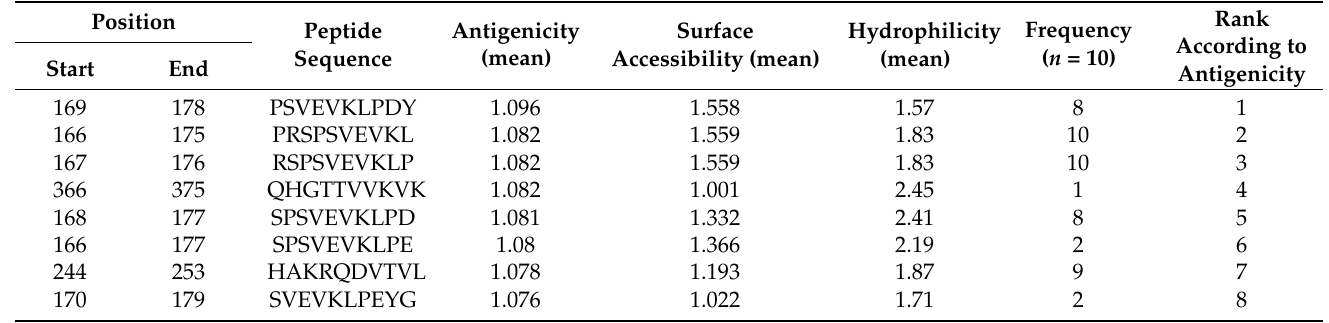
Table 4. Antigenicity, surface accessibility, hydrophilicity, and frequencies of top epitopes of DENV-4 E